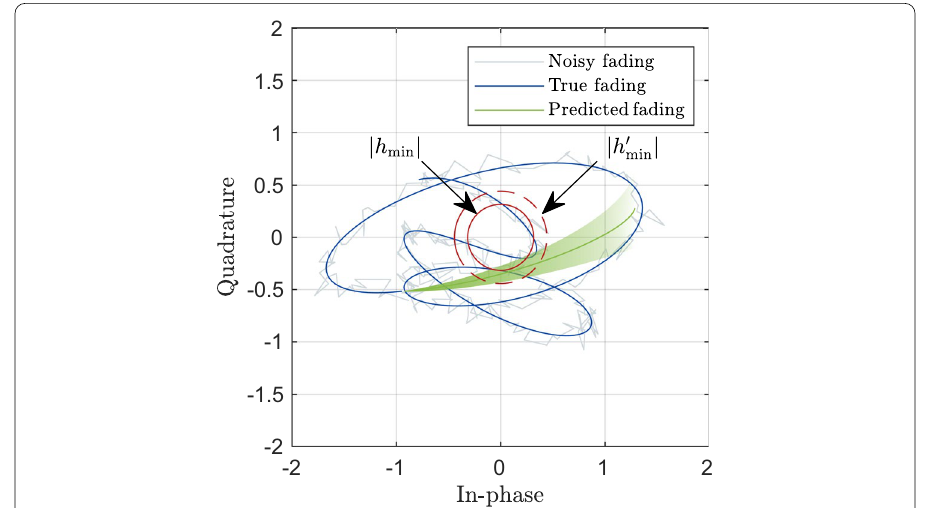
Fig. 5 Outage prediction concept. A threshold for the prediction | h ′ min | different from the outage threshold | h | is introduced to tune the prediction uncertainty min